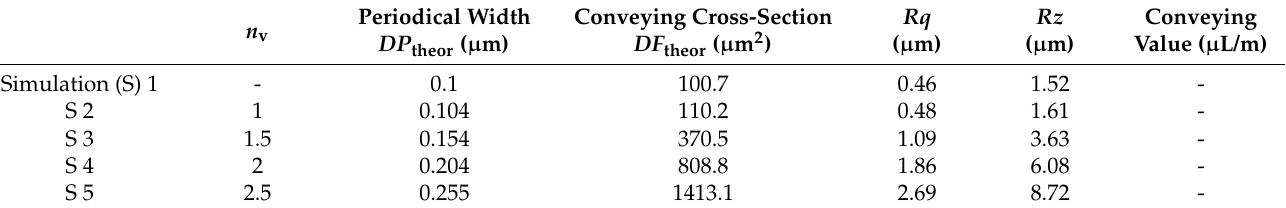
Table 5. Overview of the simulations and the results of surface characterization.